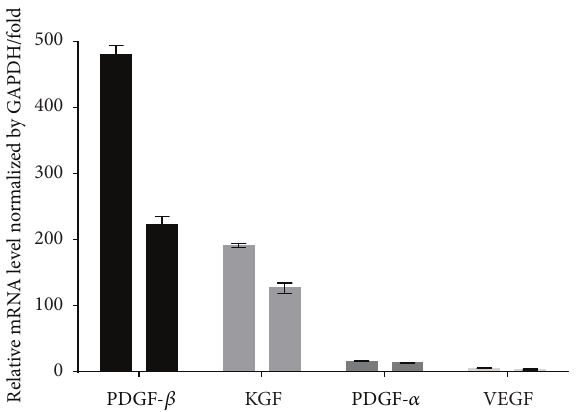
Figure 4: The mRNA profile of wound-healing related growth factors analyzed by real-time PCR and normalized by its relative ratio to GADPH in CM-treated (left) and UC-MSC-treated (right)